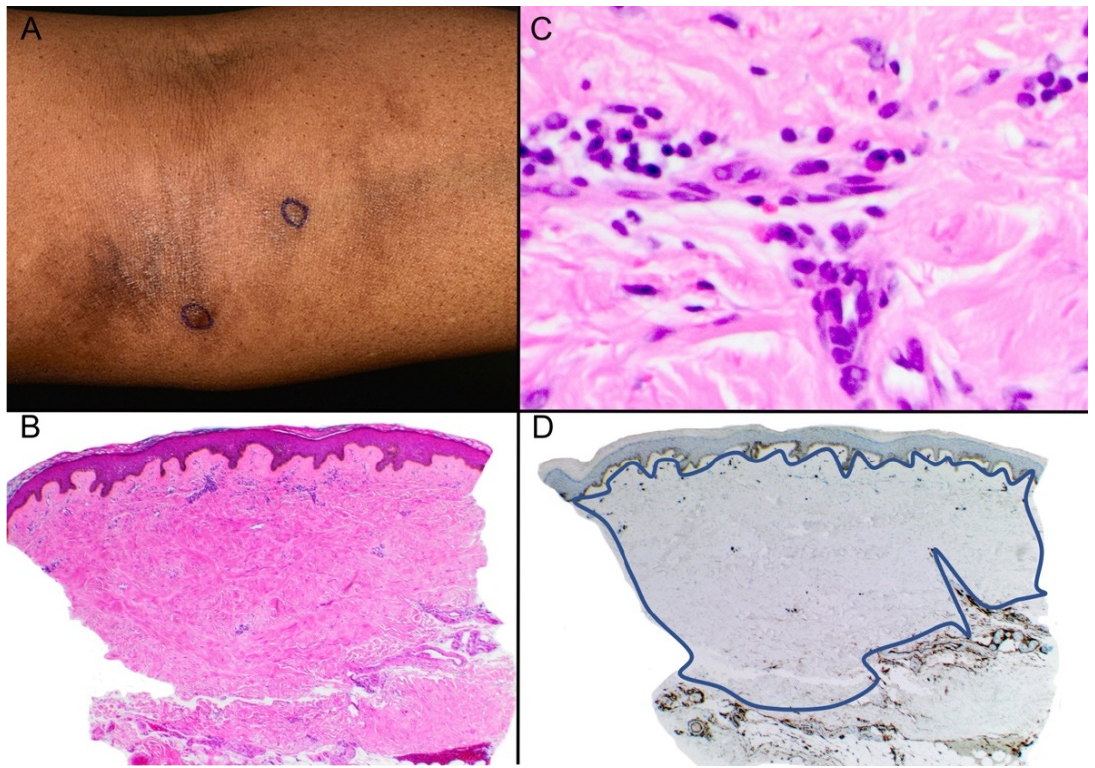
Figure 3. ( A ) Hyperpigmented area seen in the left upper inner arm. ( B ) Histopathologic examination shows hyperkeratosis and acanthosis with diffuse thickening of the superficial and deep dermis with loss of adnexal structures. (H&E) × 40. ( C ) Thickening of the collagen bundles with hyalinization is present with a mild interstitial cell infiltrate composed of lymphocytes and plasma cells (H&E) × 400. ( D ) CD34 expression is diffusely absent in the dermis (as demarcated by the blue line) × 40.